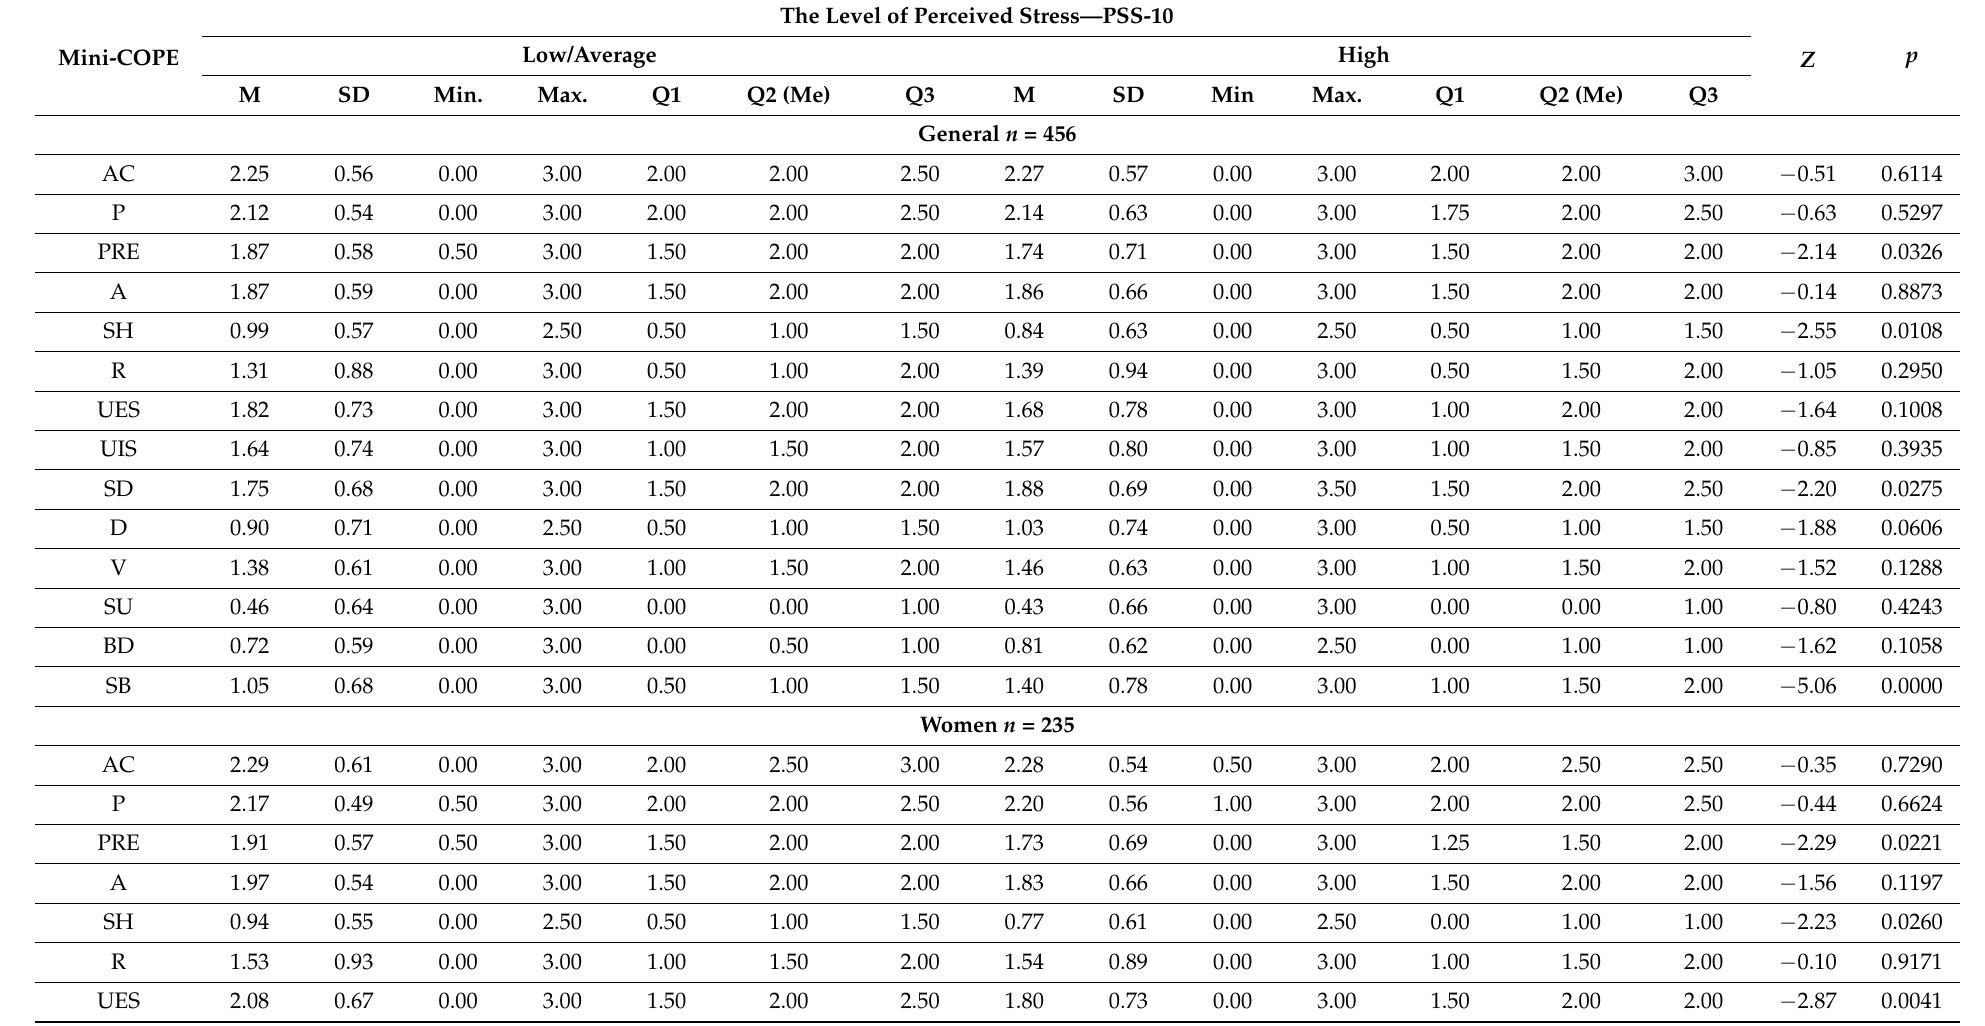
Table 5. The level of perceived stress and strategies of coping with difficult situations (14